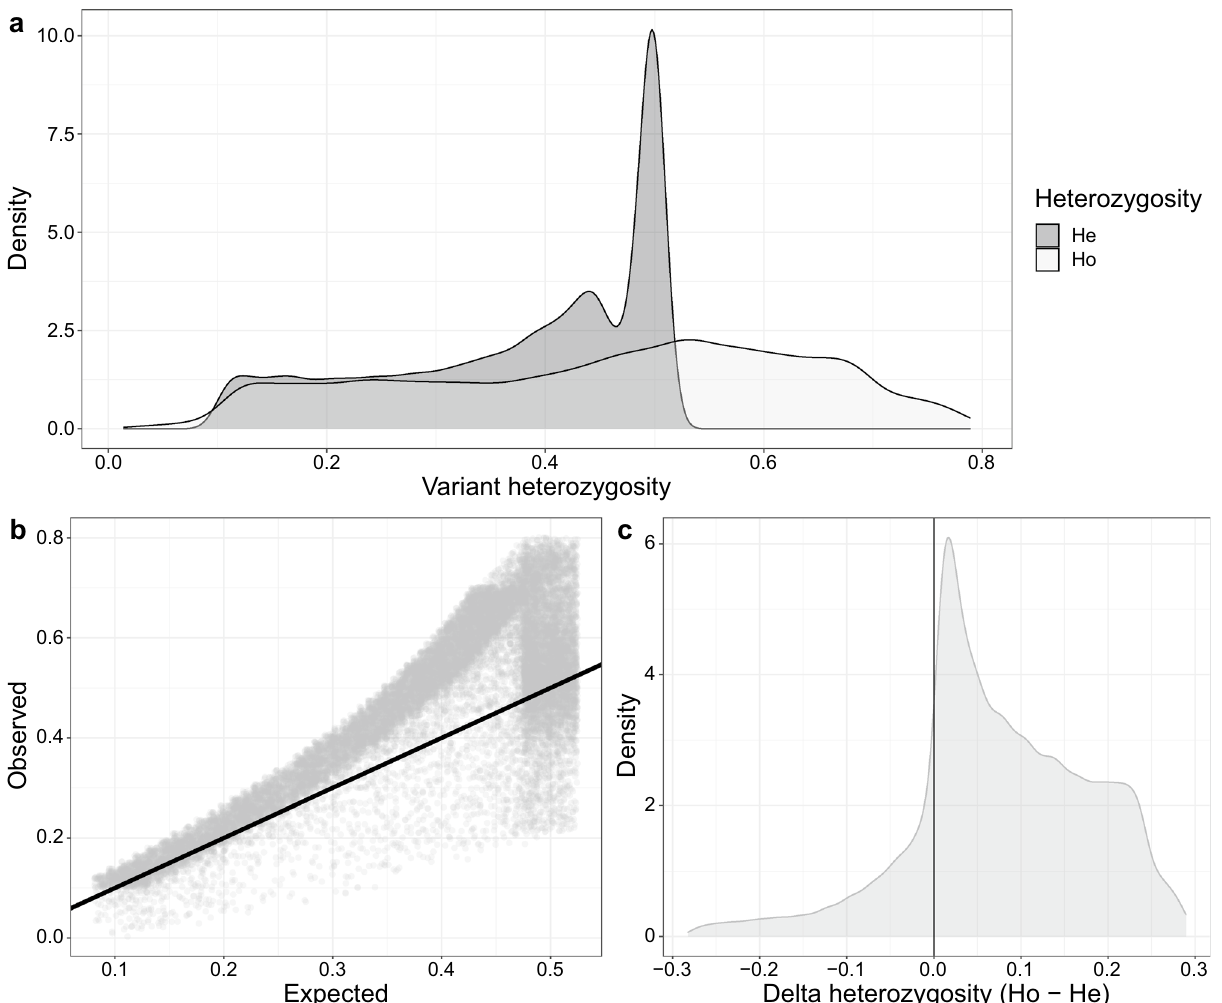
Figure 1. Distribution of heterozygosity across a subset of single nucleotide polymorphisms (SNPs) of whole genome sequences in African wild dogs ( Lycaon pictus) from Kruger National Park (KNP), South Africa. ( a ) Density of observed heterozygosity (H O ) and expected heterozygosity (H E ) across 86,149 SNPs. ( b ) Scatter plot representing the correlation of observed and expected heterozygosity of the subset of SNPs. ( c ) Distribution of delta heterozygosity (Δ = H O − H E ) across